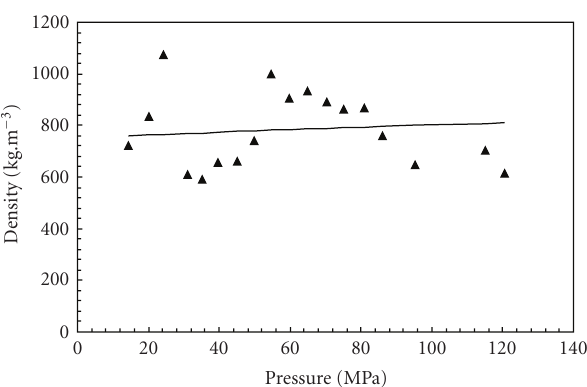
Figure 7: Deviation of evaluated density ( (cid:2) ) with literature data ( ) for n-dodecane.